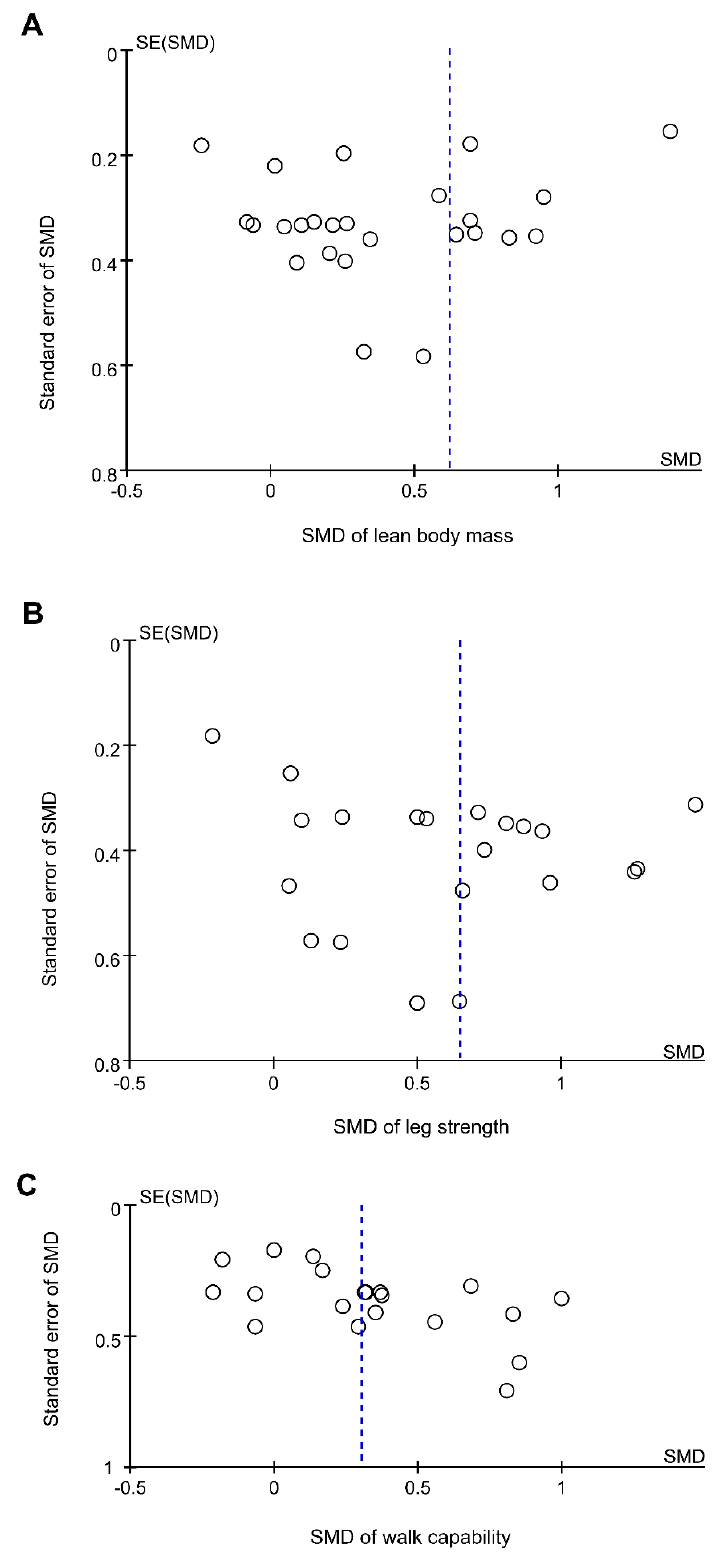
Figure 6. Funnel plots of the intervention effects for ( A ) lean body mass, ( B ) leg strength, and ( C ) walk capability. Each circle represents an independent comparison, with the x -axis representing standard mean difference (SMD) the over control comparisons and the y -axis showing the standard error (SE) of SMD. The vertical dotted line indicates the mean value of the SMDs.